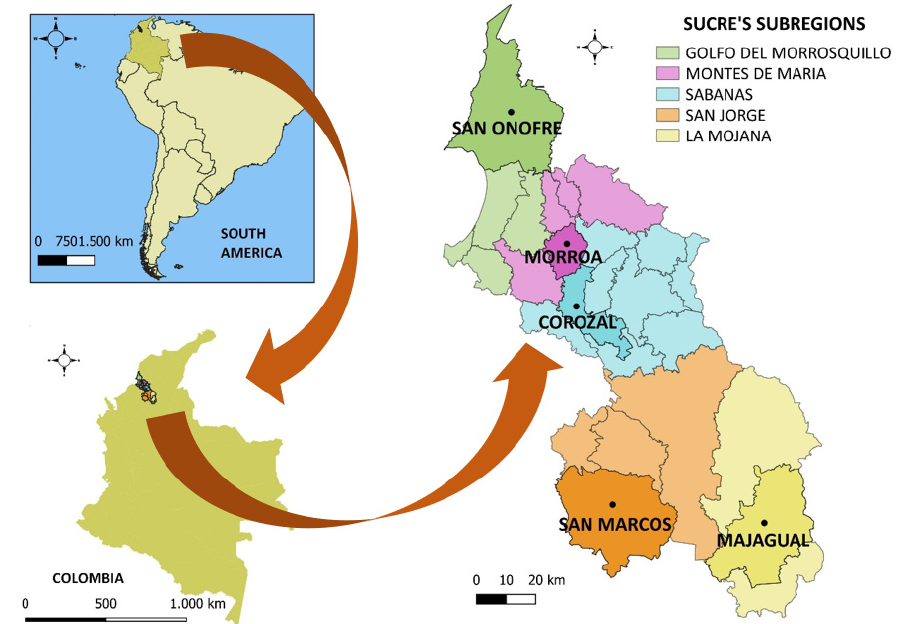
Fig. 2: Geographic location of the study area in the Department of Sucre in northern Colombia